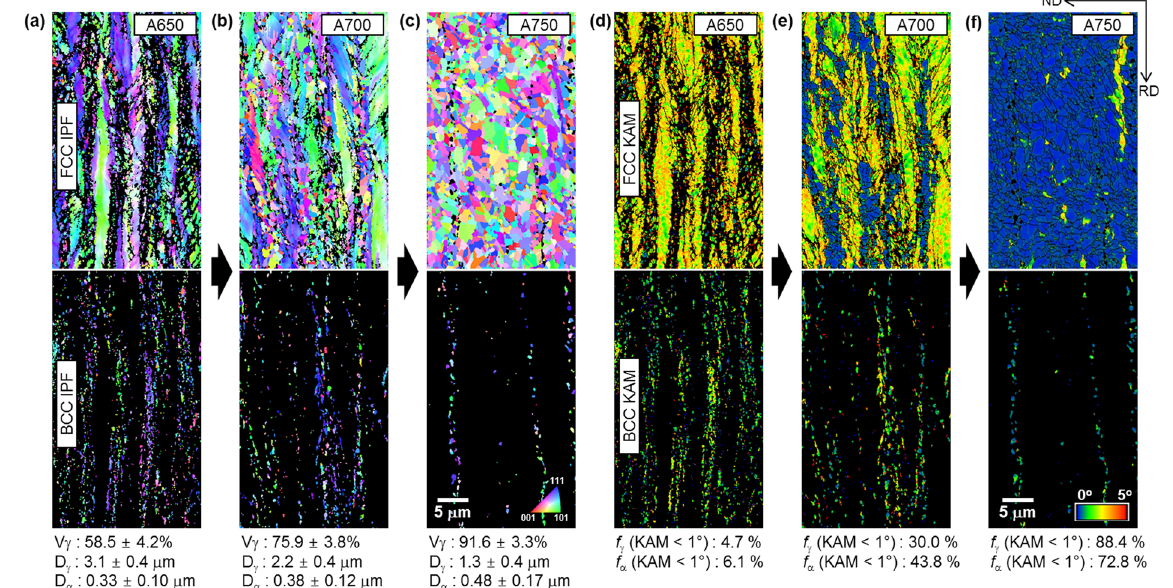
Figure 1. Microstructures of annealed duplex steels. ( a – c ) EBSD inverse pole figure (IPF) maps of austenite and ferrite, together with grain sizes of austenite and ferrite (D γ and D α ). Austenite and ferrite grains are elongated parallel to the rolling direction, and ferrite grains are extremely small. ( d – f ) EBSD kernel average misorientation (KAM) maps of austenite and ferrite. High KAM valued regions containing elongated grains and low KAM valued regions containing equi-axed grains indicate non-recrystallized and recrystallized regions,